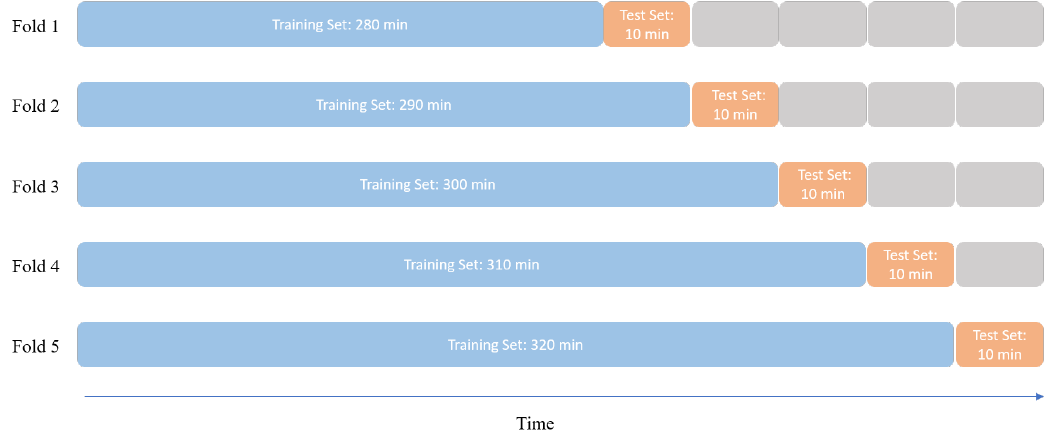
Figure 6. Diagram for the Rolling cross-validation.